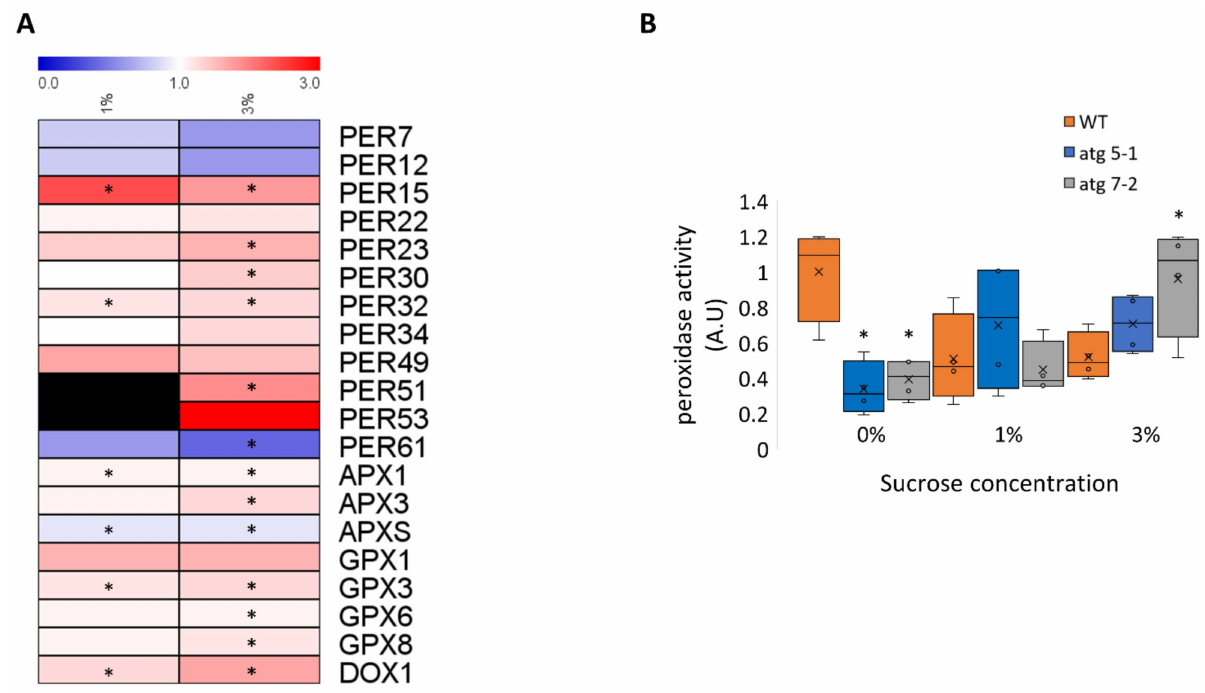
Figure 8. Root peroxidase activity is increased in atg mutant plants under sucrose excess ( A ). Heatmap describing the fold-change in peroxidase levels between atg5-1 and WT under 1% and 3% sucrose. Black boxes indicate peroxidases that were not detected. An asterisk denotes a significant change between WT and atg5-1 , as determined by Student’s t -test. ( B ). WT, atg5-1 , and atg7-2 plants were sown on Nitsch plates containing 0%, 1%, or 3% sucrose and grown vertically for 10 days. Roots were collected and the peroxidase activity was assessed. An asterisk denotes a significant difference from WT under the same treatment, as determined by Dunnett’s test ( p < 0.05, n = 4), x indicates sample mean, and circles denote